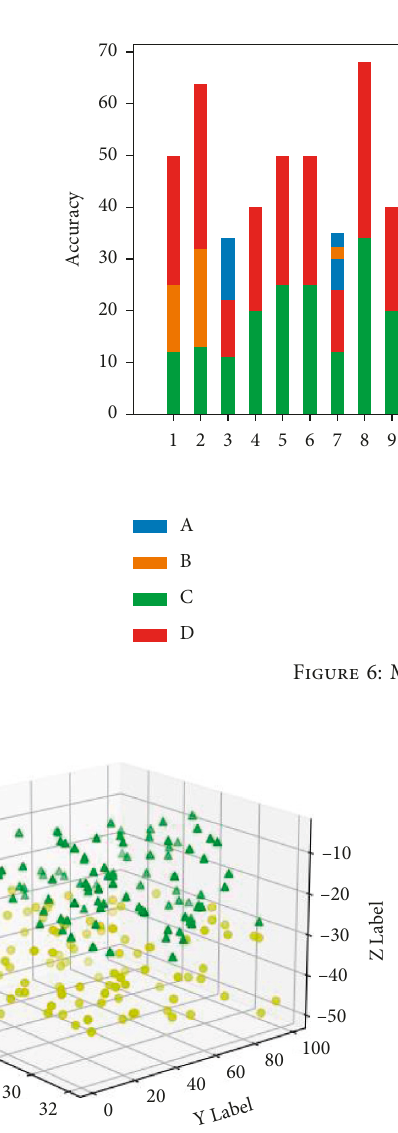
Figure 7: The relationship between word spelling and pronunciation.